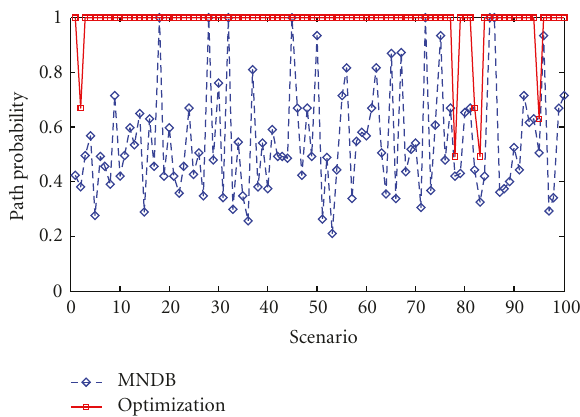
Figure 8: Path probability optimization versus MNDB per scenario, P t = 20 dBm .